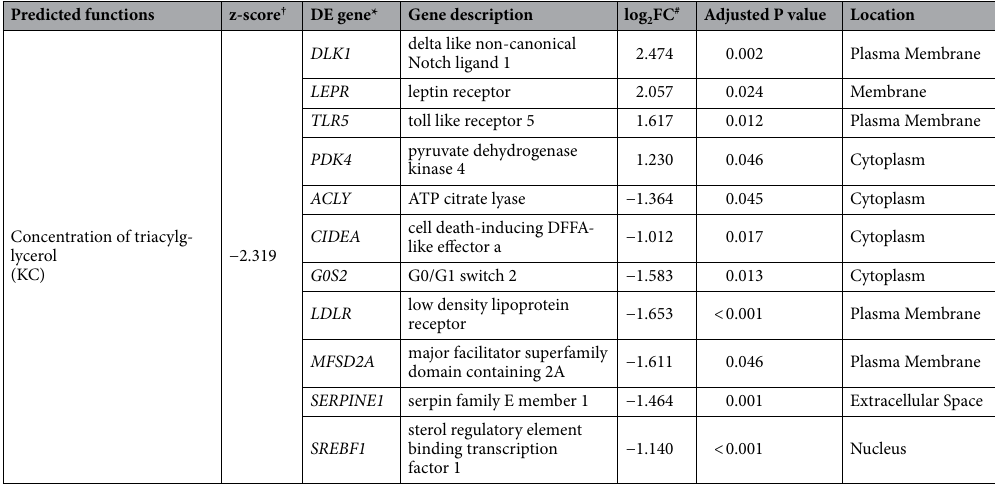
Table 5. Predicted function of differentially expressed (DE) genes in subcutaneous adipose tissue of involved in the predicted lipid metabolic function using IPA. † z-score ≥ 2 and z-score ≤ − 2 indicate Activated and Inhibited activation state. *Differentially expressed genes were based on pairwise comparison between H- and L-RFIfat with FDR ≤ 0.1 and |log 2 FC|≥ 1 as cut-off. # Log 2 FC ≥ 1 and log 2 FC ≤ − 1 indicate up- and down- regulation of a gene in L-RFIfat compared to H-RFIfat steers,